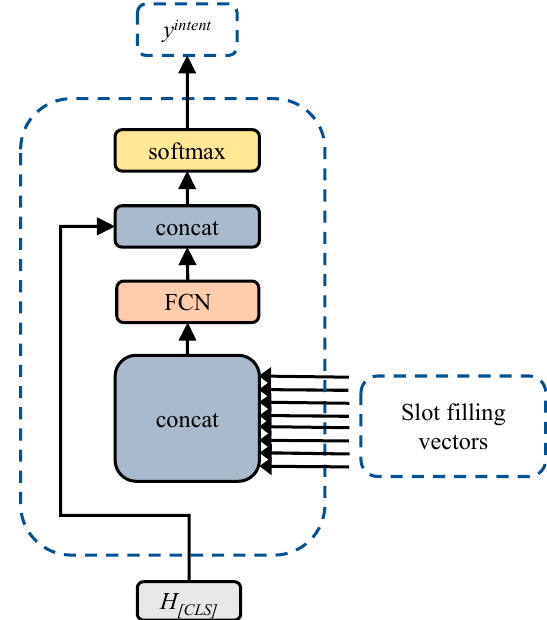
Figure 4. Semantic feature fusion for intent tasks.